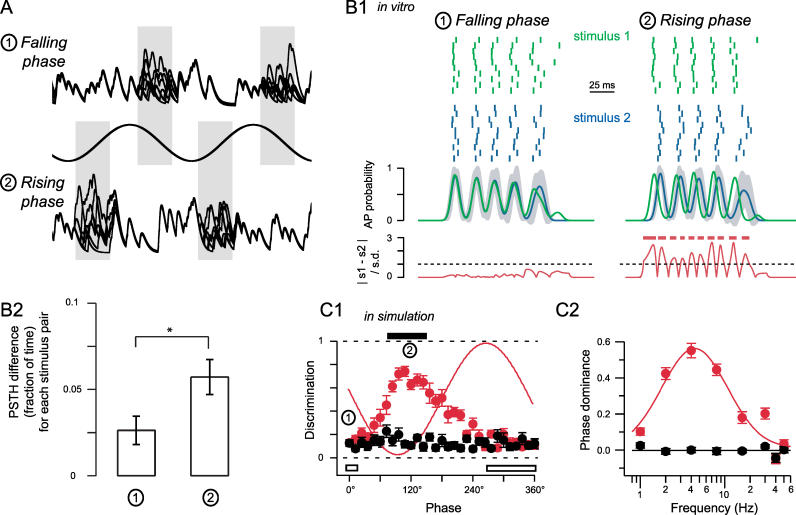
Oscillation Phase Is Critical for Optimal Discrimination(A) Two examples of input waveforms, each containing seven stimulus input trains (overlaid) that differed only during the indicated 100° windows (centered around −20° for the peak/falling phase situation (1) and 160° for the rising phase situation (2); the phase was measured relative to the downward midline crossing of the oscillatory drive).(B1) Rasters from an in vitro recording from a CA1 pyramidal neuron. The two stimuli only differ in the phase window indicated in (A). (Middle panels) PSTHs for both stimuli; the gray shading indicates the SD of the PSTH for stimulus 2. Note that while for the falling phase (1) both PSTHs overlap, they are easily separable for stimuli differing in the rising phase (2). (Bottom panels) Difference between the two PSTHs normalized to the combined SD. Red bars indicate where this normalized difference is larger than 1, that is, regions where the two stimuli are discernible based on the PSTHs.(B2) Summary of the in vitro recordings for the PSTH difference (the fraction of time where the normalized difference between the two PSTHs is larger than 1) for 22 stimulus pairs. The PSTH difference for rising phase stimuli is significantly larger than for falling phase stimuli (
p < 0.05).
(C1) Stimulus discrimination is plotted under control and oscillation conditions as a function of the phase of the window for simulations in an InF neuron. A sinusoidal fit to the membrane potential is shown as a thin red line for reference. Stimulus windows similar to those shown in (A) are indicated by (1) and (2). To allow for higher temporal resolution the phase window was reduced to 60° and varied in steps of 12° across the cycle. Phase is measured relative to the downward midline crossing of the MPO. Solid bar indicates a period of best discrimination, while the open bar shows the period for the oscillatory case where discrimination is relatively poor.(C2) A sinusoid is fitted to the discrimination–phase plot. “Phase dominance” is defined as the peak-to-trough amplitude of the fitted sinusoid and plotted as a function of the oscillation frequency. As a control, the black line indicates the average phase dominance in the absence of a MPO. The red line is a Gaussian fit on a lin-log scale.